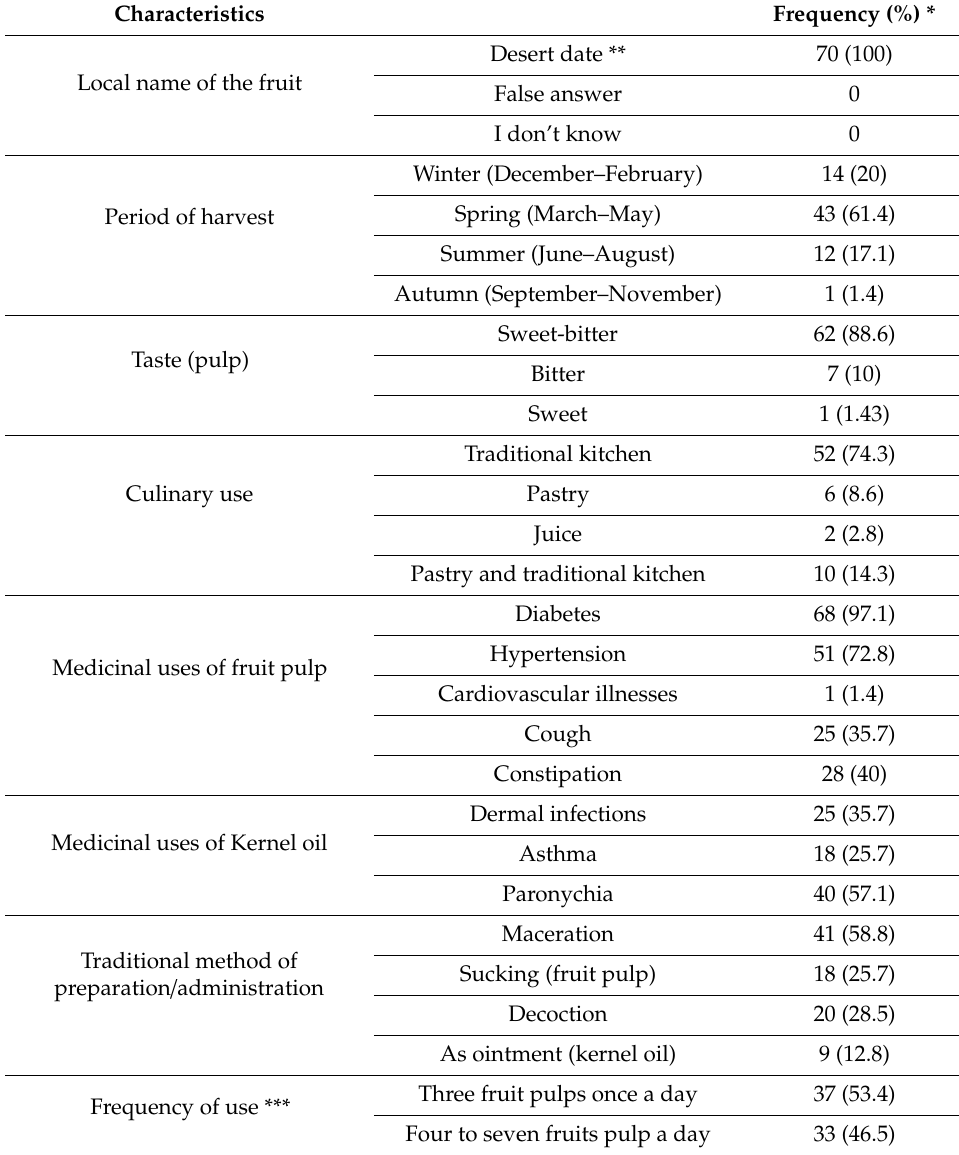
Table 5. Ethnobotanical and medicinal uses of the fruit of B. eagyptiaca reported by 70 informants from Nouakchott, Mauritania, Northwest